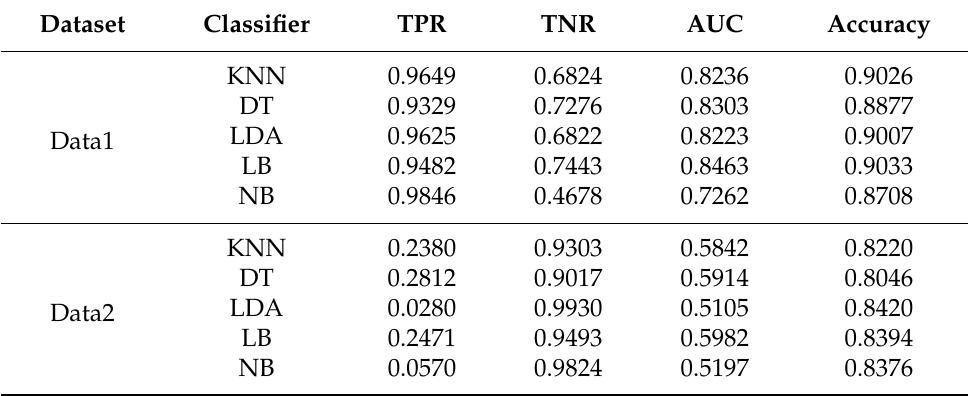
Table 5. Evaluation results of classification methods without re-sampling and without